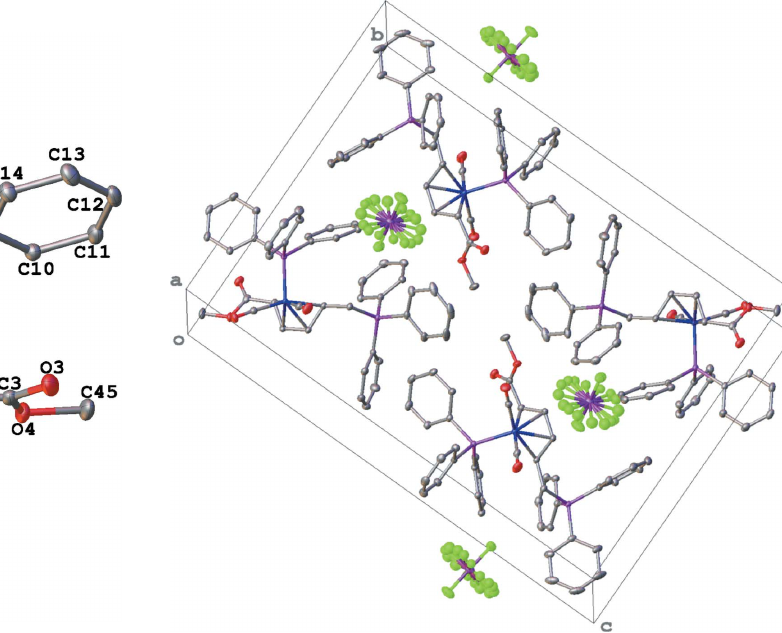
Figure 2 Packing diagram of the title compound.